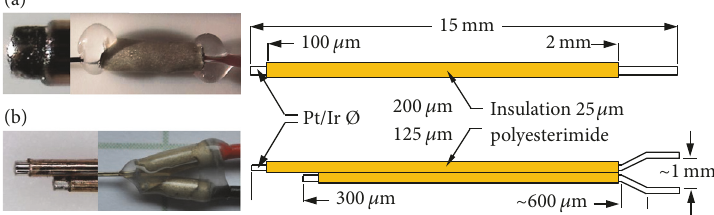
Figure 1: Photographs of tips (left), distal connections (center), and schematic drawings (right) of (a) the unipolar (200 𝜇 m wire diameter) and (b) the bipolar microelectrode (125 𝜇 m wire diameter). The electrode shafts were insulated with 25 𝜇 m polyesterimide. All electrode tips were bare for 100 𝜇